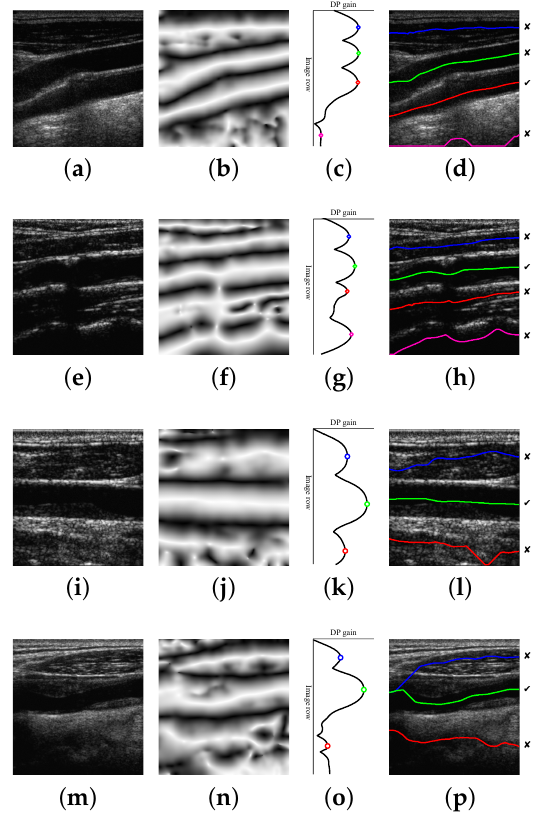
Figure 8. Candidate lumen detection examples. From left to right: ( a , e , i , m ) input image; ( b , f , j , n ) symmetry map; ( c , g , k , o ) DP gain profile; and ( d , h , l , p ) resulting candidates, indicating which one is closer to the true lumen (the one marked with (cid:51) ). Images ( a ) and ( e ) result in candidate detections with 100% of correct points. Images ( i ) and ( m ) result in candidate detections slightly touching the plaque boundaries: ( l ) at the image center and ( p ) at the left of the image.